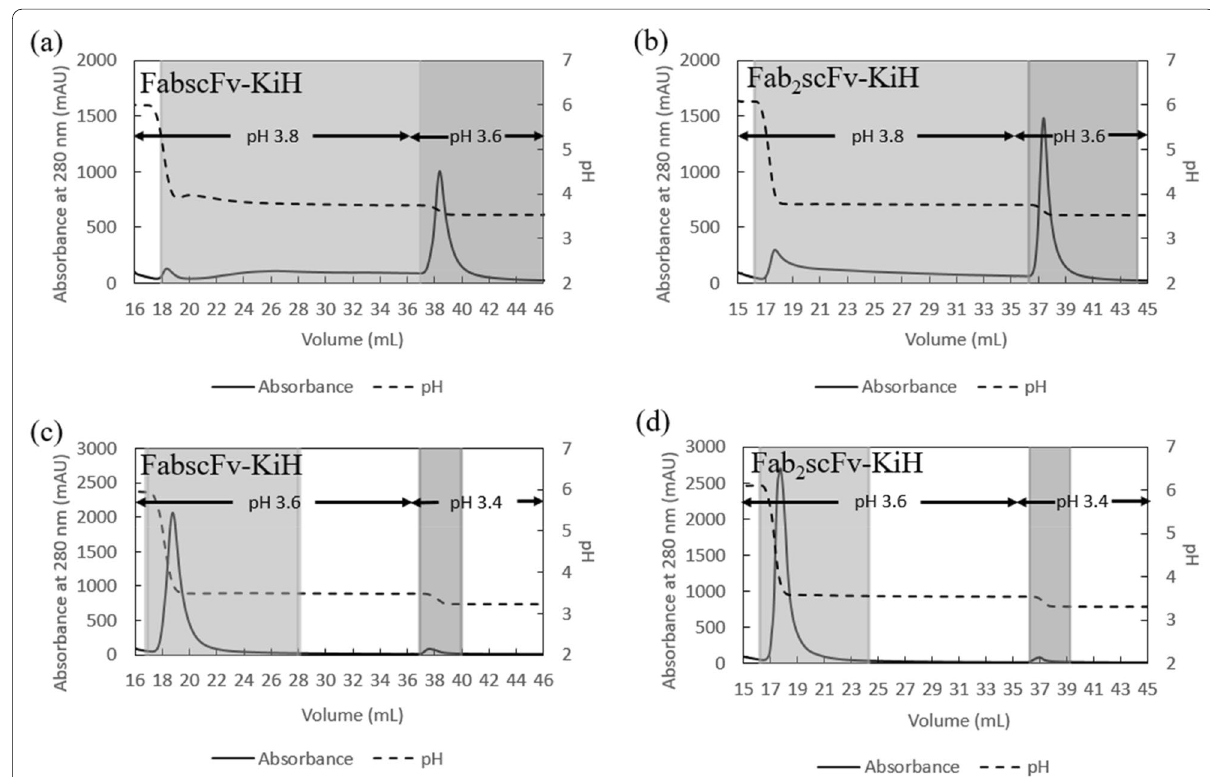
Fig. 3 AKTA chromatograms of MabSelect PrismA runs with a 2-step pH elution. A 2-step elution of pH 3.8 and pH 3.6 for FabscFv-KiH ( a ) and Fab